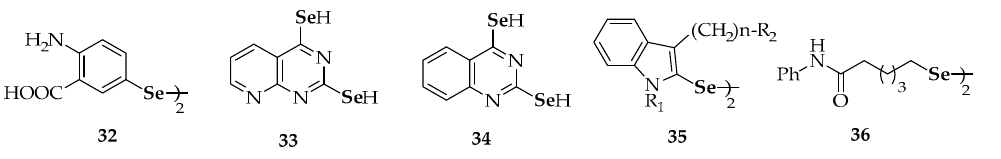
Figure 3. Synthetic diselenides and related selenols with kinase modulation properties [73–76].